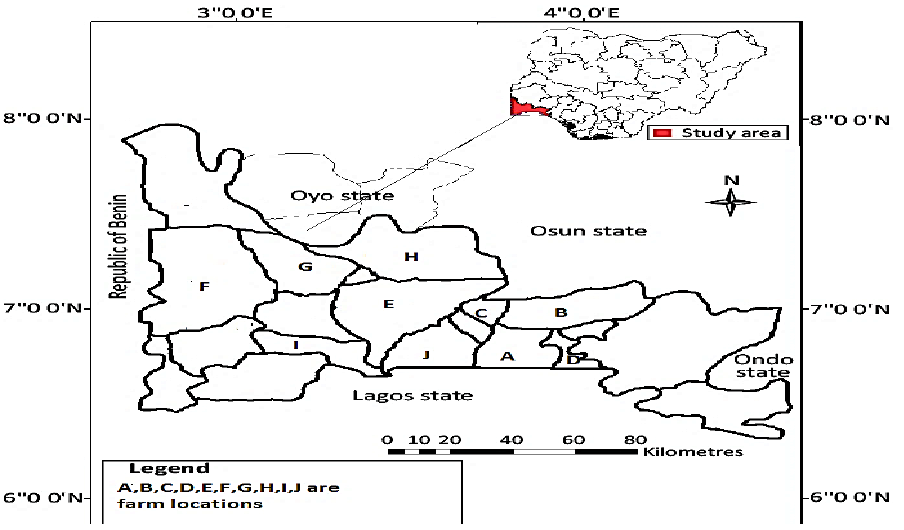
Figure 1. Map of the Study